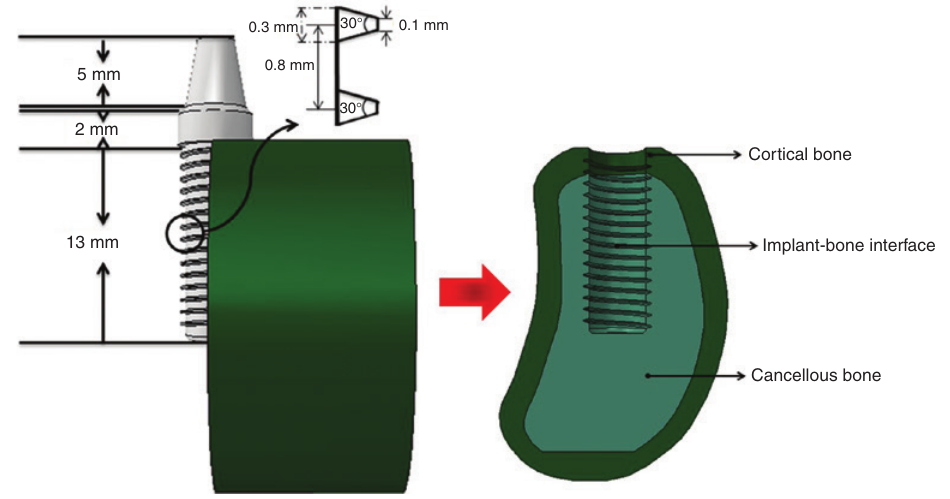
Figure 1: Details of the dental implant/bone system simulation.